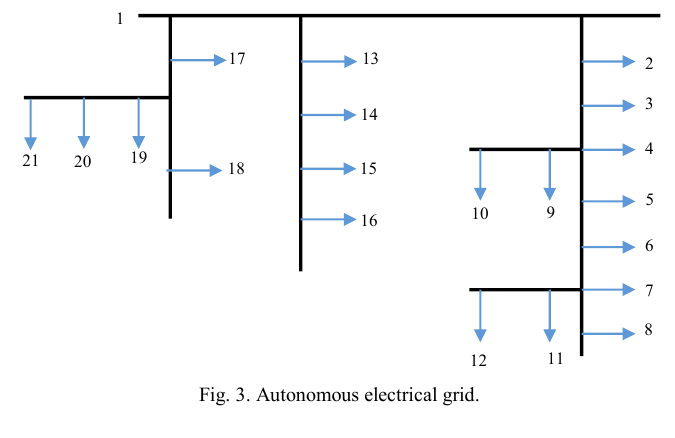
Fig. 3. Autonomous electrical grid.